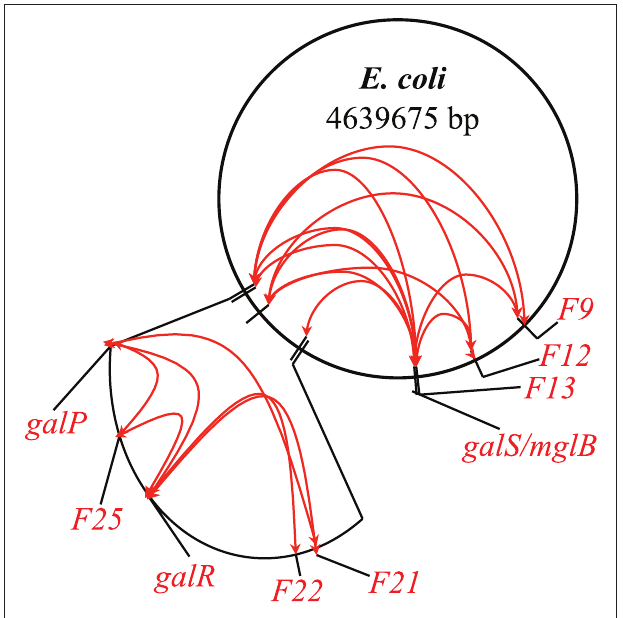
FIGURE 3 | Inter-segmental DNA networks by GalR in E. coli . The network was determined by 3C assays (see text) and is shown by red lines. Only a subset of the GalR-mediated intersegmental operator connections are shown. TABLE 1 | List of GalR operators identified by 3C